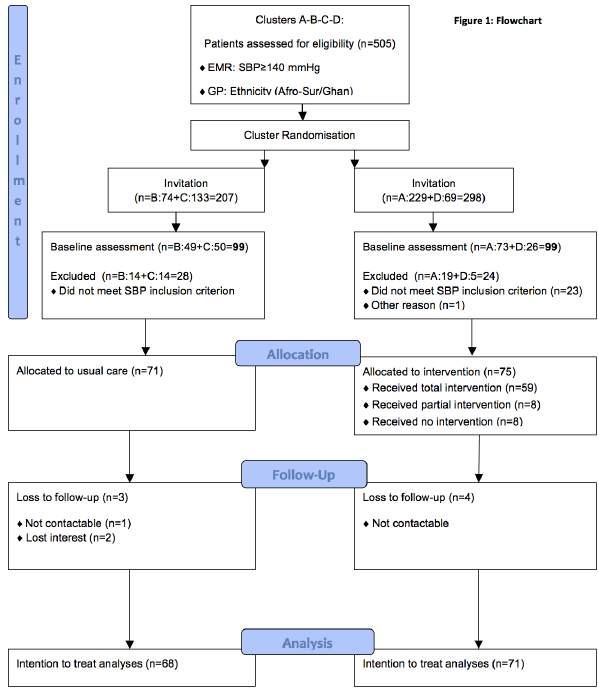
Figure 1. Flowchart.